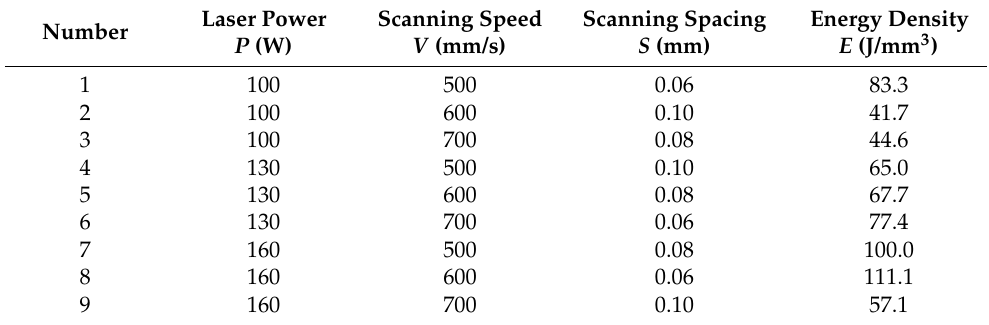
Table 1. Orthogonal parameter design.